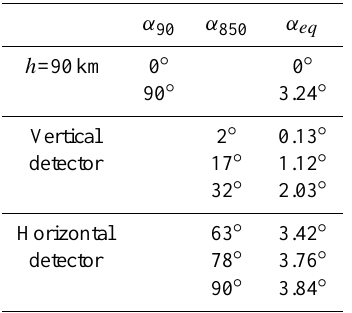
Table 4. Pitch angle relationships assuming the first invariant ∝√ B ) and a dipole ( sin(α)